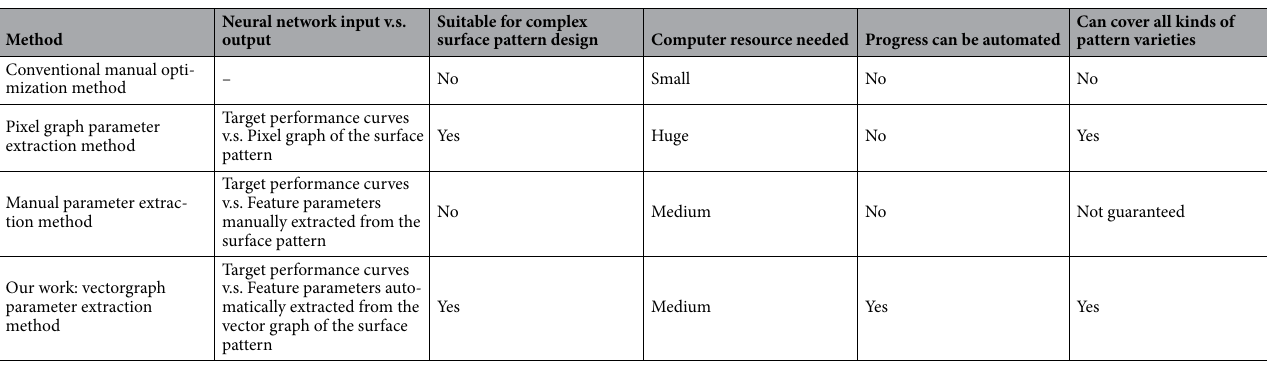
Table 1. Comparison of the proposed method to the conventional metamaterial design method as well as two other AI design